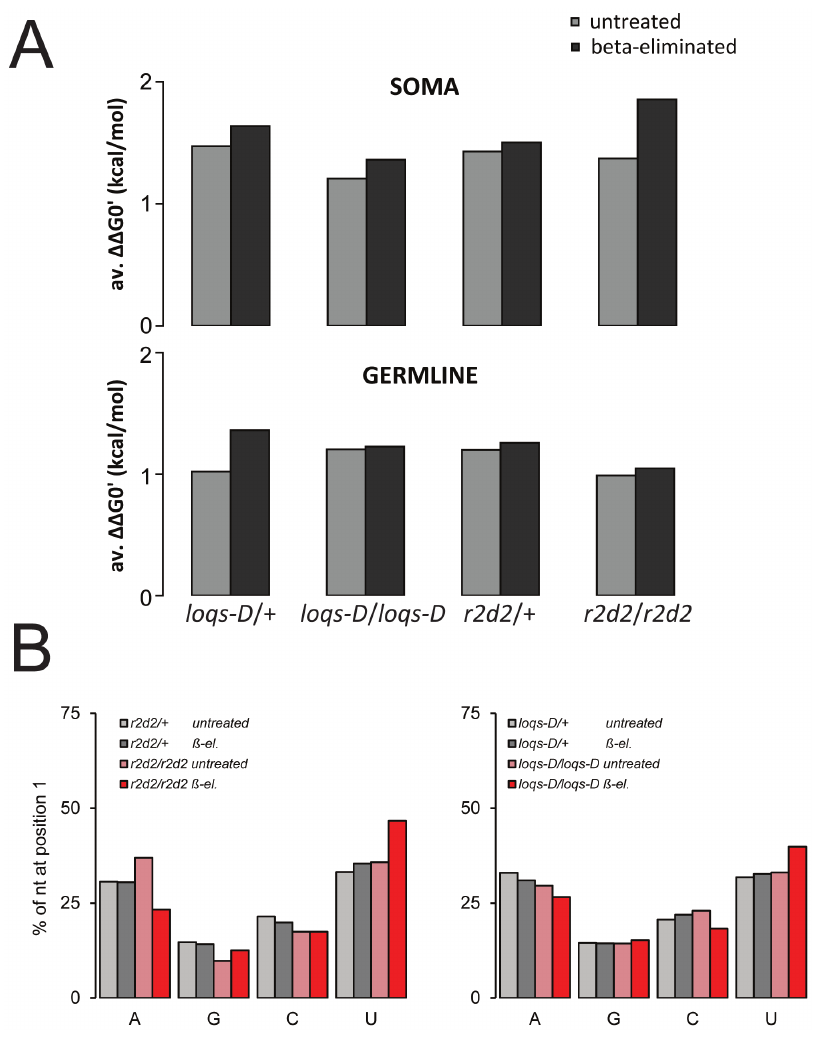
Figure 2. Analysis of strand asymmetry and 5’-nucleotide preference in deep sequencing data. A) The thermodynamic asymmetry was calculated for transposon mapping endo-siRNAs of the indicated genotypes. We calculated the difference in free energy of duplex formation at either end of the presumed siRNA precursor for each sequence read using the nearest neighbor method [51], then calculated the average difference ( DD G0’). A positive value indicates that on average the 5’ ends of the reads are less stably base paired than the opposite ends. B) The relative frequency for each nucleotide at the 5’-end is depicted as a function of genotype and RNA treatment.